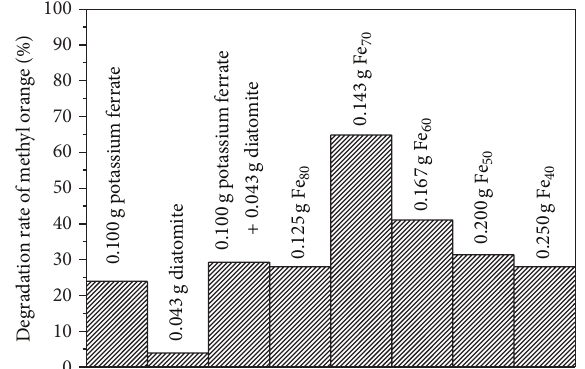
Figure 5: Removal rate of methyl orange using different treatments. (Experimental conditions: methyl orange concentration = 20 mg/L, solution volume = 500 mL, and reaction time = 20